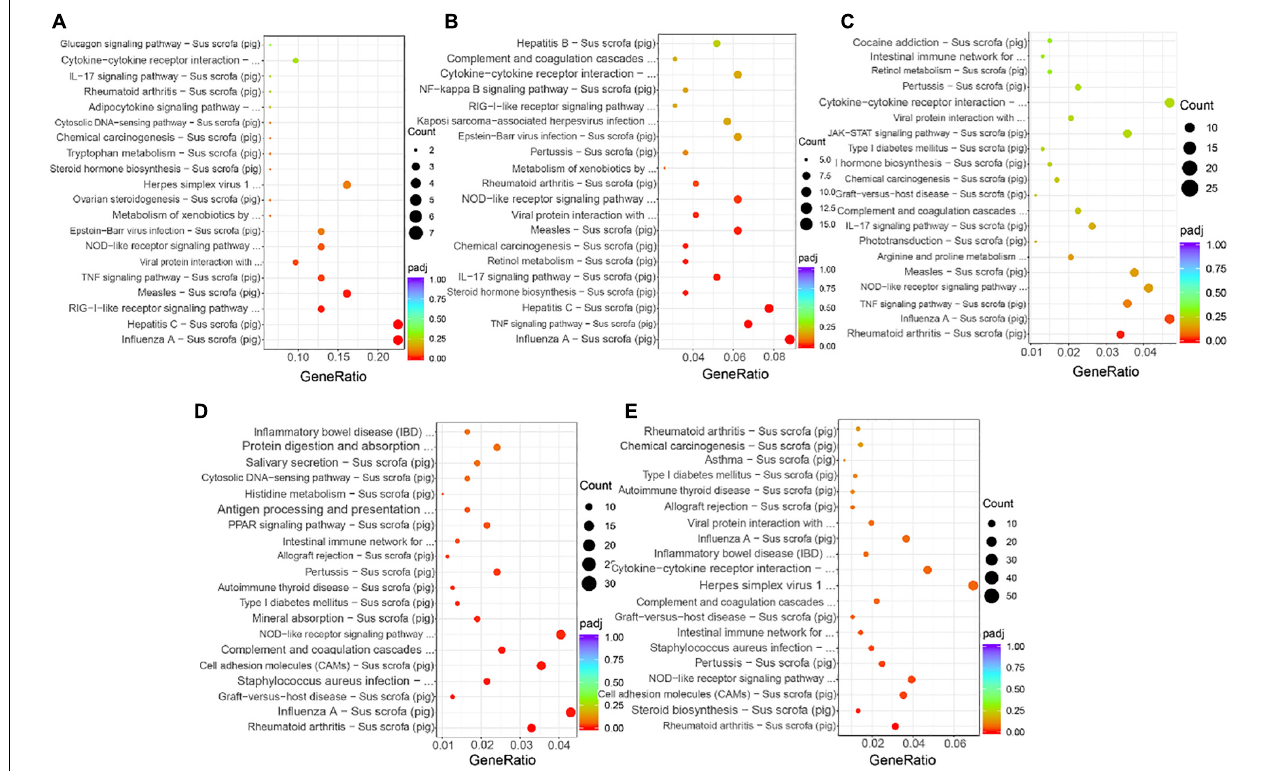
FIGURE 5 | KEGG pathway enrichment analysis. The x -axis represents the ratio of the DEGs in this pathway to the total DEGs, and the y -axis represents different KEGG pathways. The dot size represents the gene number. (A) Top 20 enriched pathways in S6 vs. Control. (B) Top 20 enriched pathways in S12 vs. Control. (C) Top 20 enriched pathways in S18 vs. Control. (D) Top 20 enriched pathways in S24 vs. Control. (E) Top 20 enriched pathways in S36 vs. Control.